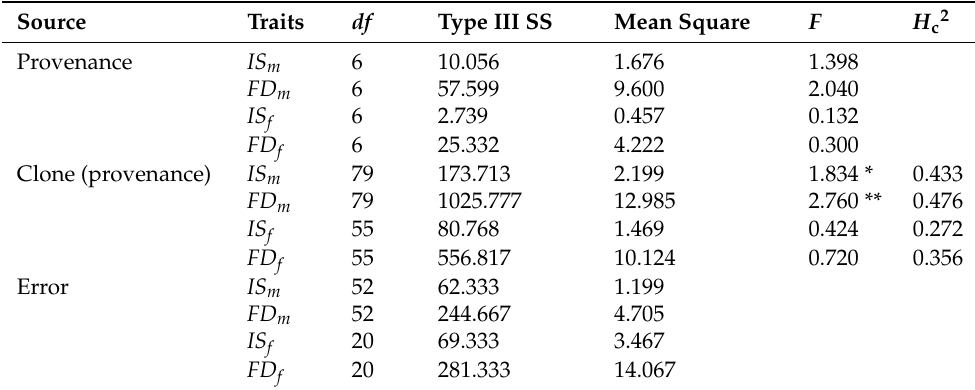
Table 3. GLM-based ANOVA for the initial stage and flower duration.